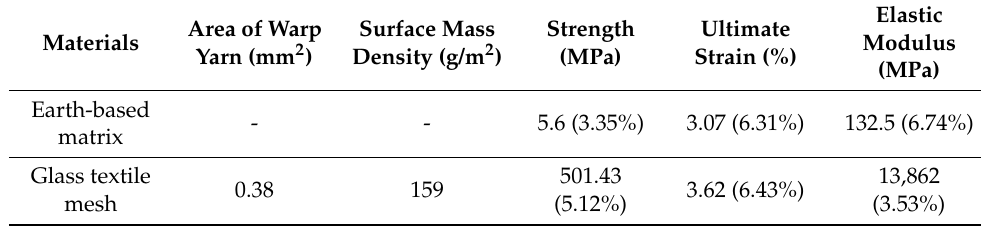
Figure 2. Preparation of the materials: ( a ) compressive test of earth-based mortar, ( b ) textile detail, ( c ) tensile test of single yarn. Table 1. Mechanical properties of earth-based matrix and glass textile mesh [“()” indicates